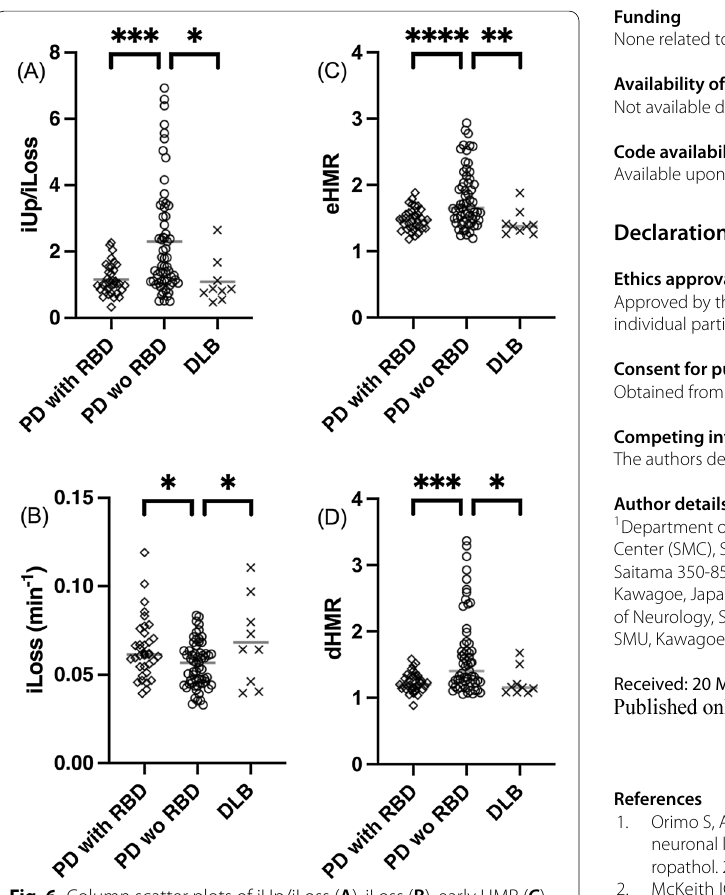
Fig. 6 Column scatter plots of iUp/iLoss ( A ), iLoss ( B ), early HMR ( C